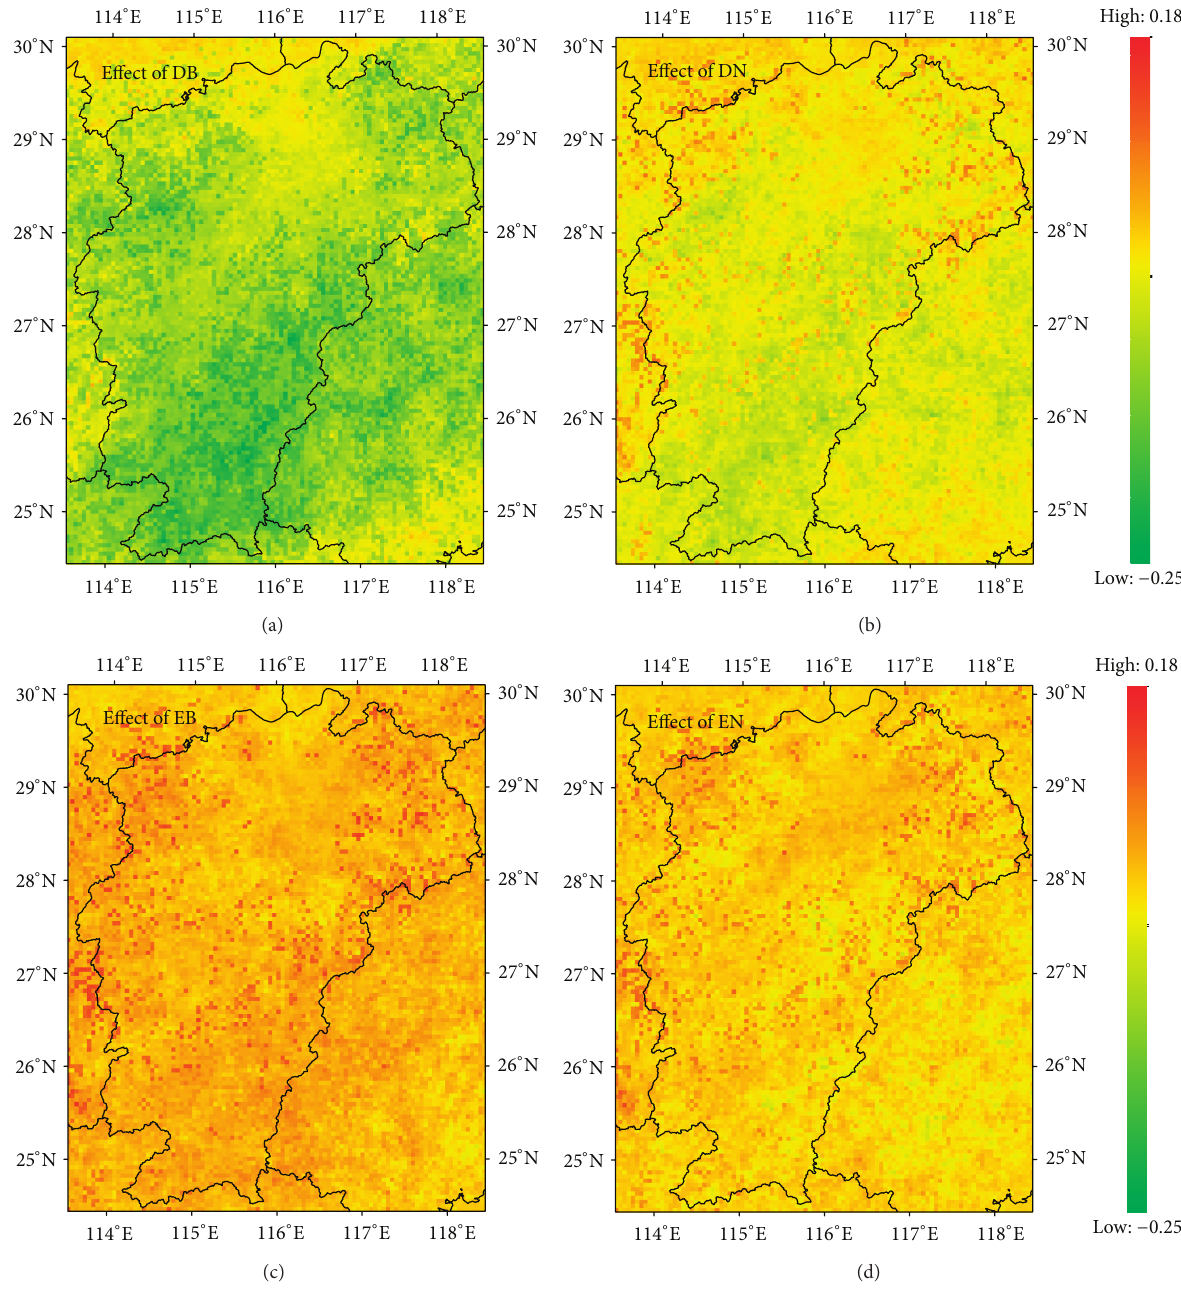
Figure 2: Simulated effects of afforestation on the annual average temperature (measured in degrees Celsius) in Jiangxi Province.